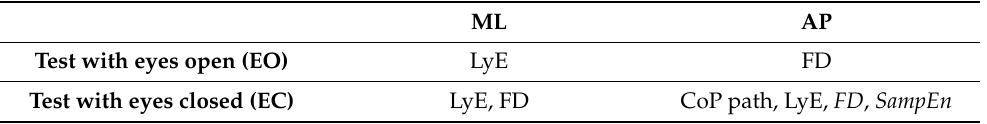
Table 6. Discriminant model summarized according to test conditions and direction. Non-significant variables are marked with